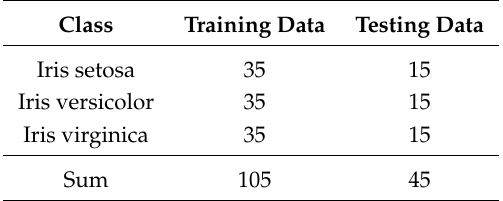
Table 9. Training and testing sets of the Iris dataset.